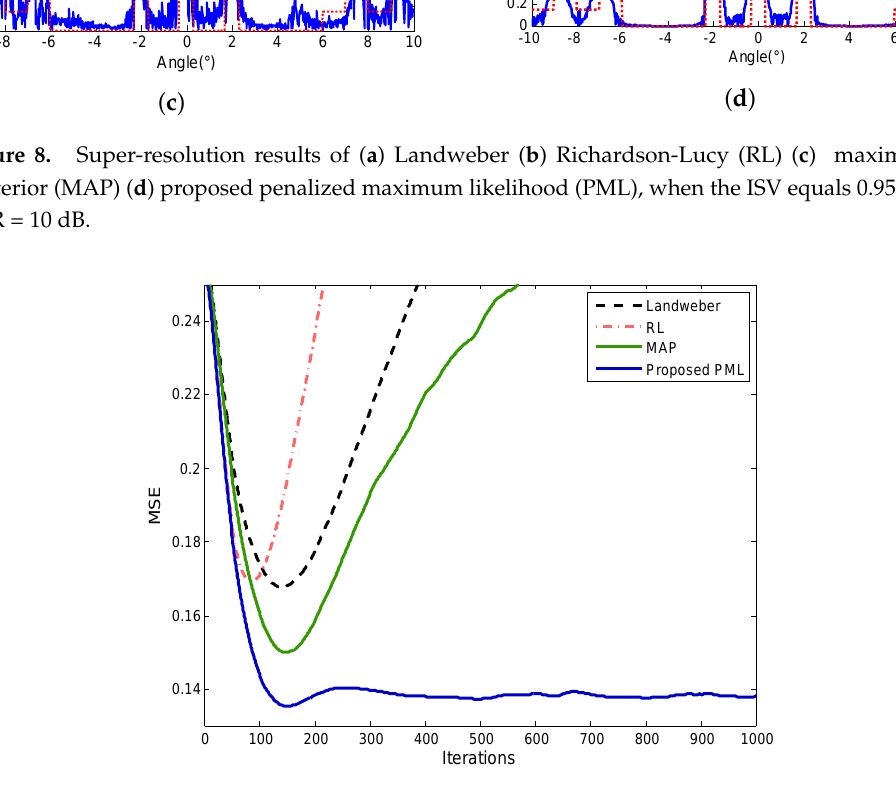
Figure 9. MSE curves comparison when SNR = 10